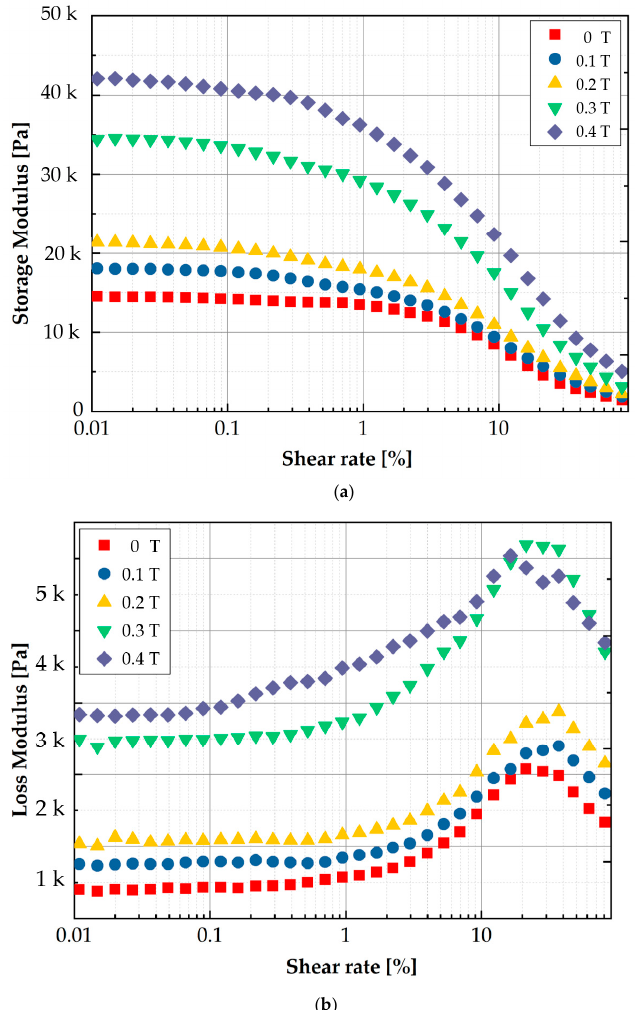
Figure 6. Measured viscoelastic properties of MRE (50 wt%): ( a ) storage modulus ( b ) loss